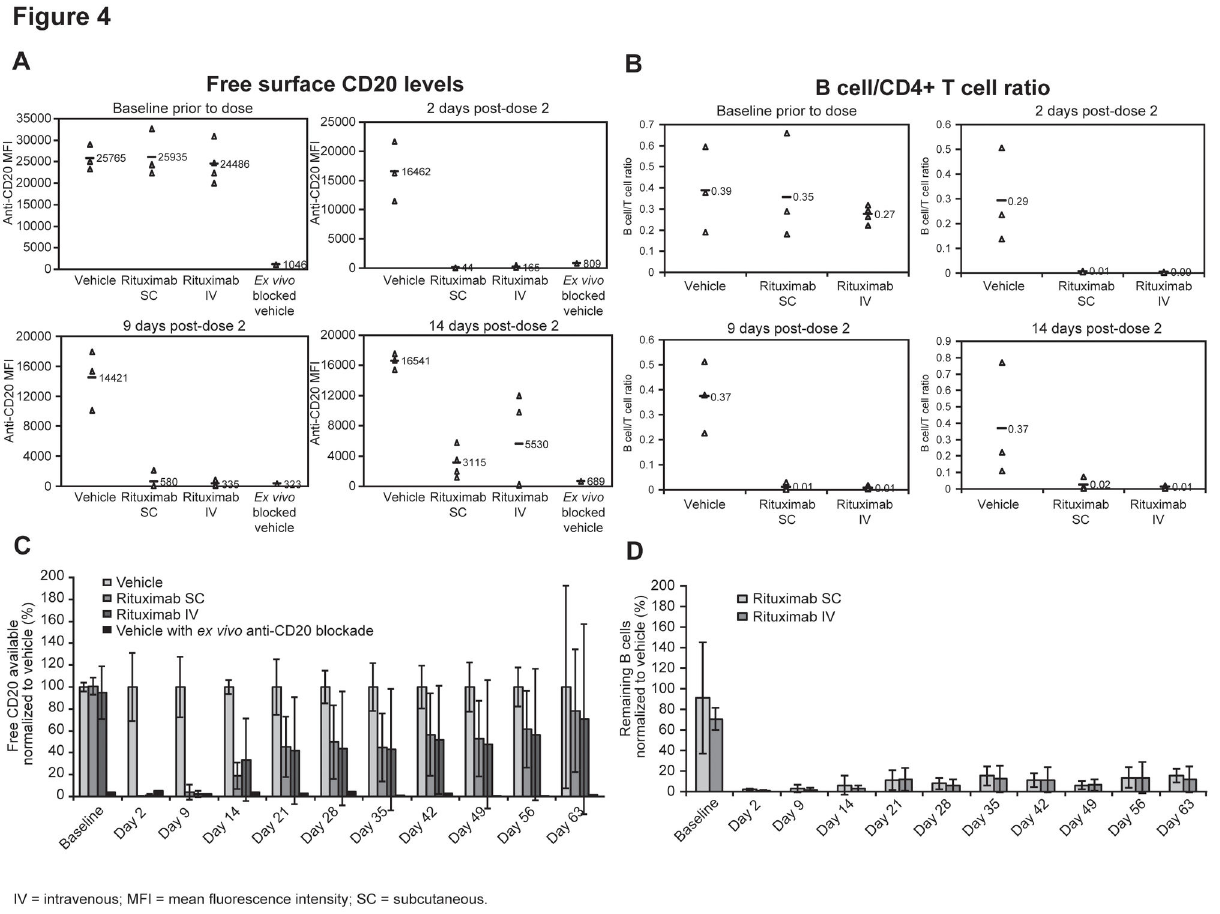
Figure 4. CD20 target coverage and B-cell depletion in Peripheral Blood. PBMC analysis of ( A ) CD20 target coverage as determined by flow cytometric staining for free surface CD20 levels on (B cells identified as in Figure 2A) and ( B ) depletion of those PBMC B-cells at baseline and 2, 9, and 14 days after second dose of subcutaneous or intravenous rituximab as determined by a ratio to CD4+/CD3+ T cells (Individuals animal samples with mean shown (n=4 rituximab treated groups, n=3 PBS vehicle treated groups)); and long-term PBMC analysis of ( C ) percent free surface CD20 target coverage and ( D ) percent remaining B-cells out to 63 days; normalized to PBS vehicle (group mean ± SD (n=4 rituximab treated groups, n=3 PBS vehicle treated groups)) with ex-vivo rituximab treatment of PBS vehicle sample to show maximal target